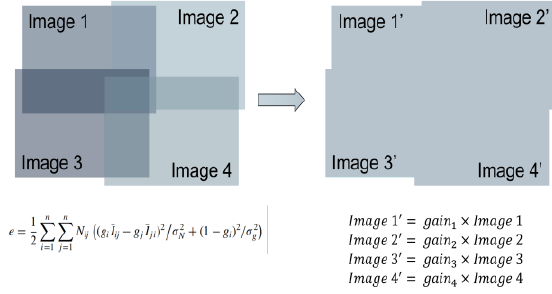
Figure 3. Concept of gain compensation